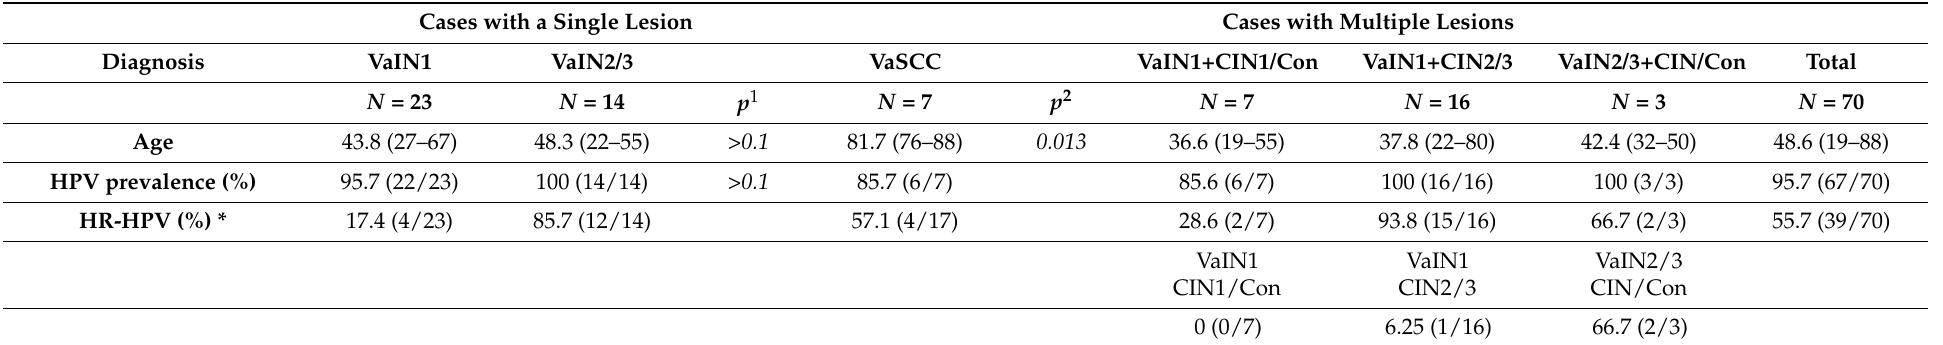
Table 2. Age of patients, histological diagnosis and HPV infection by E6/E7 PCR using tissue specimens. Cases with a Single